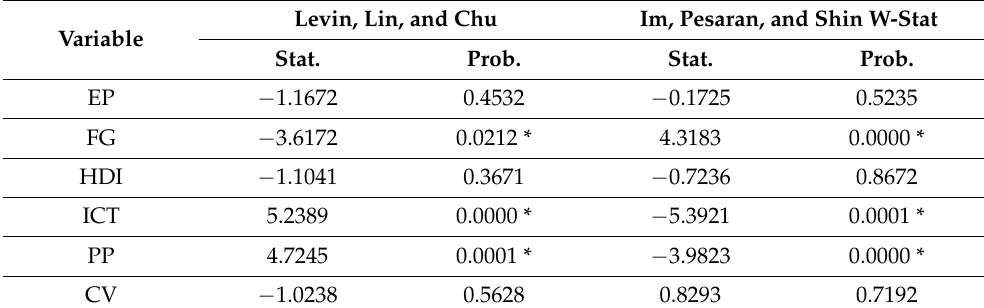
Table 3. Unit root tests.